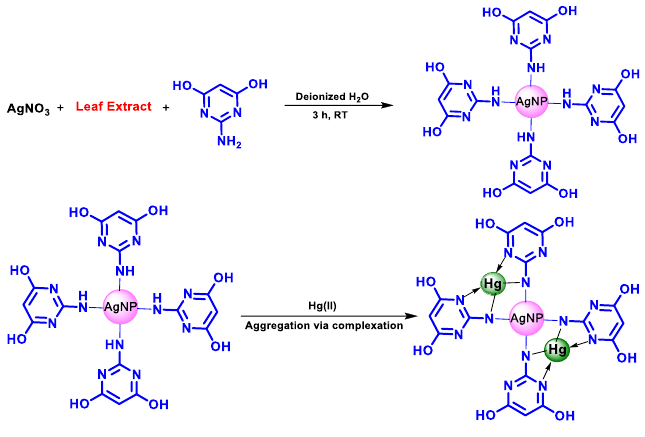
Scheme 1. Synthetic pathway of APD-AgNPs ( top ) and its Hg 2+ sensing property ( bottom